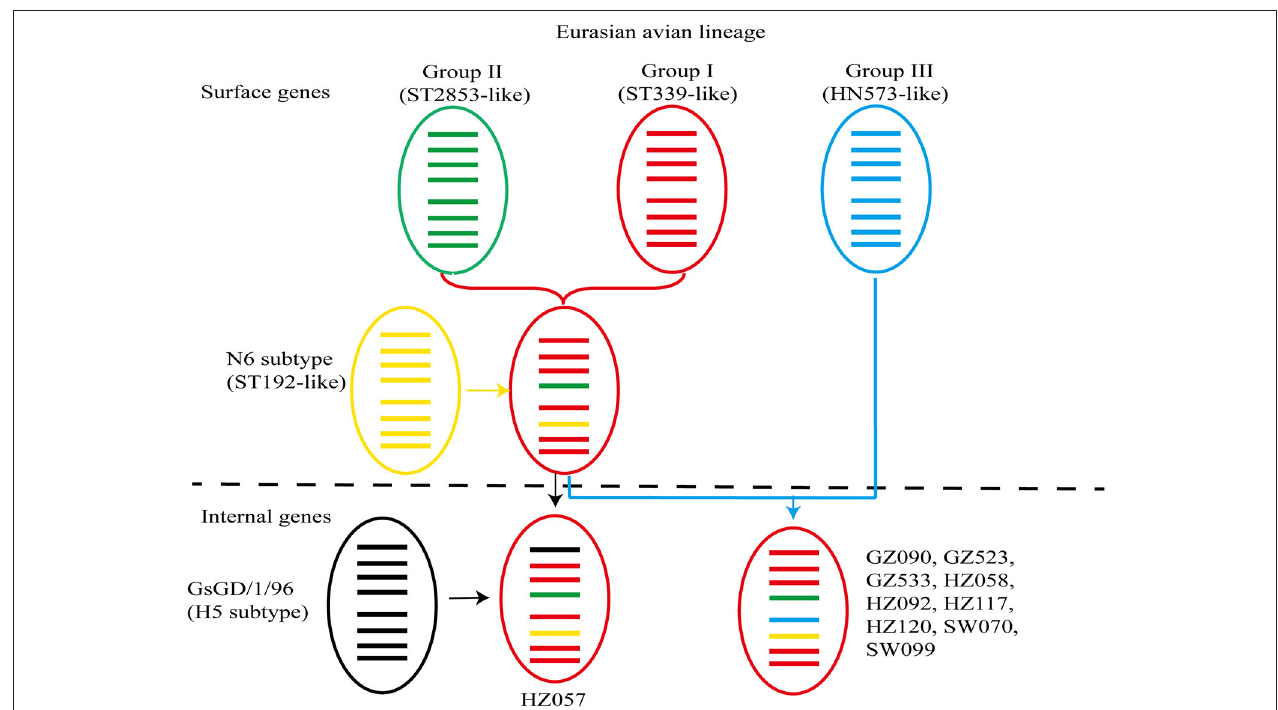
FIGURE 1 | Genetic reassortments of avian influenza virus subtype H6N6 in southern China. From top to bottom, the eight genes in each schematic virus particle are the PB2, PB1, PA, HA, NP, NA, M, and NS genes. Genes of the same lineage appear in the same color.